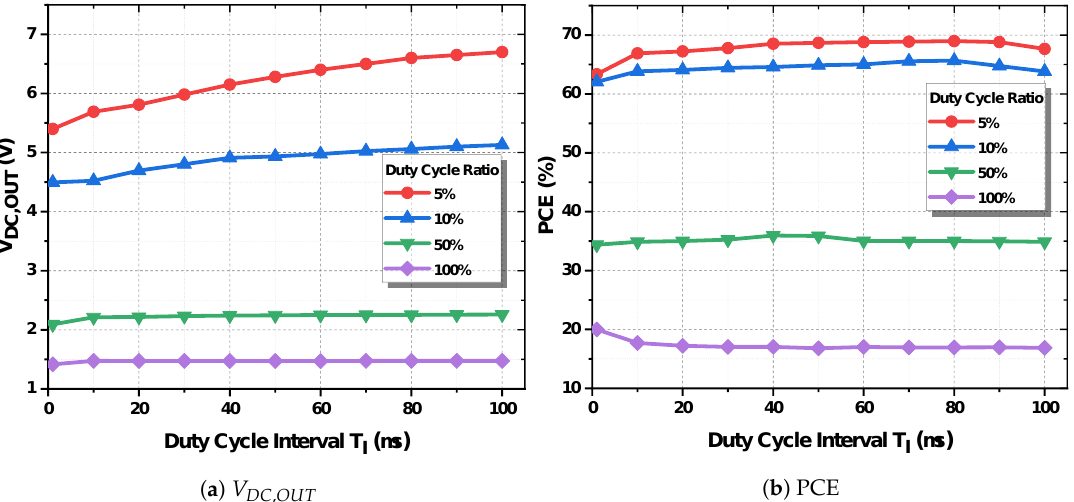
Figure 8. ( a ) V DC , OUT and ( b ) PCE of the rectifier with respect to T I the duty cycle